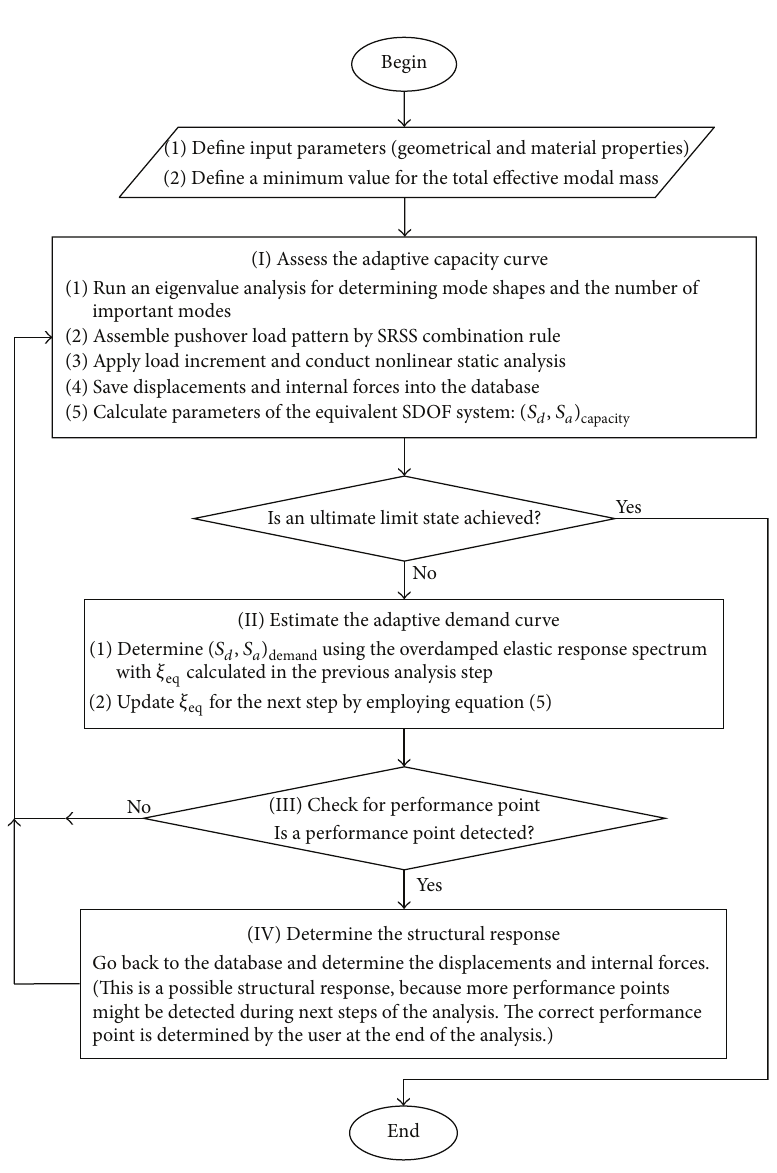
Figure 2: Flowchart of the proposed seismic assessment